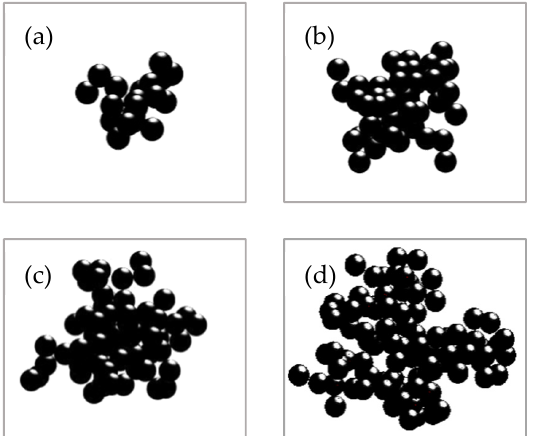
Figure 1. Particle morphologies of SiC clusters with different numbers of elementary particles: ( a ) N = 20; ( b ) N = 50; ( c ) N = 70; ( d ) N = 100.